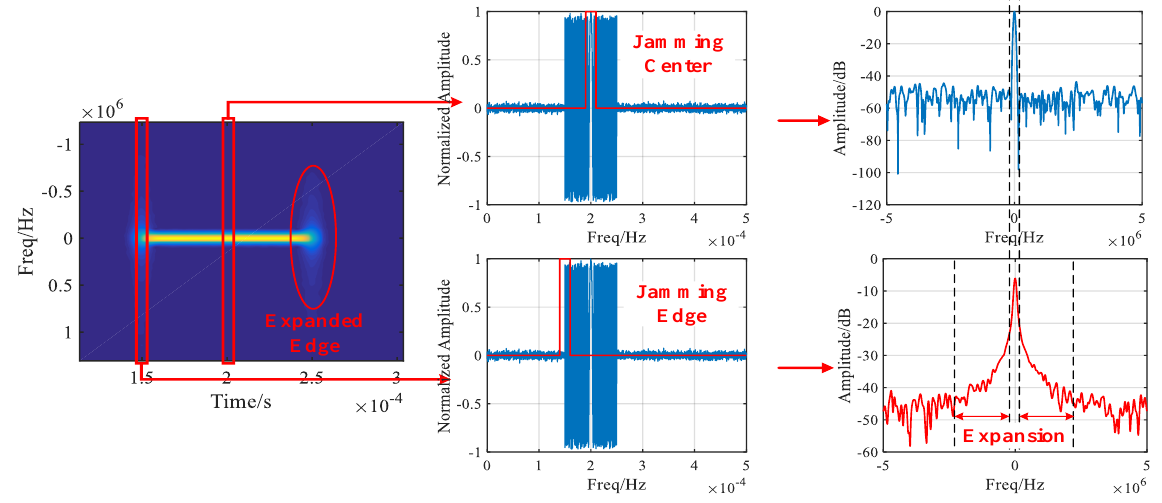
Figure 5. Edge expansion phenomenon in STFRFT spectrogram.